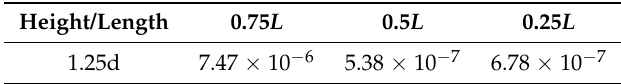
Table A5. MSE values for different source heights and lengths, shallow water